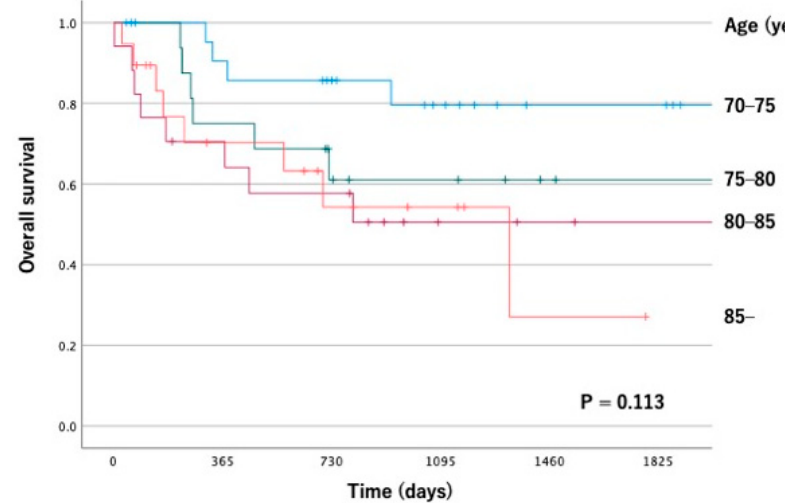
Figure 1. Kaplan–Meier survival curve according to the age group. In contrast, 5-year OS rates for each treatment modality were 82.7% for surgery, 0% for radiotherapy, and 18.8% for palliative therapy ( p < 0.01; Figure 2). Logistic multivariate analysis of the parameters with stepwise forward selection method identified three inde- pendent predictive factors for selecting surgery: serum Alb level ( ≥ 3.5 vs. <3.5) (odds ratio [OR], 42.487; 95% CI, 3.373 to 535.242; p = 0.004), PS (0, 1, 2, 3) (OR, 0.233; 95% CI, 0.067 to 0.811; p = 0.022) and clinical stage (OR, 0.278; 95% CI, 0.119 to 0.646; p = 0.003); details are shown in Table 2. Figure 2. Kaplan–Meier survival curve according to the treatment group.